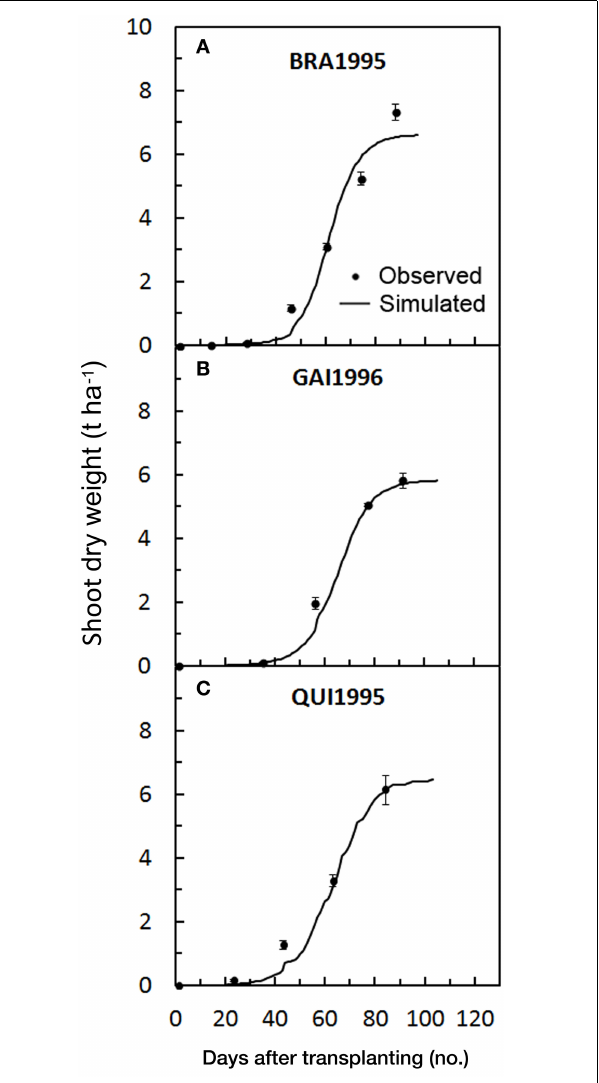
FIGURE 6 | Simulated and observed SDW accumulation during the three tomato cycles in Florida [BRA1995 (A), GAI1996 (B), QUI1995 (C)], used for validating GesCoN . Mean standard errors, when larger than the symbol, are represented by vertical bars. (Re-elaborated from Scholberg et al.,